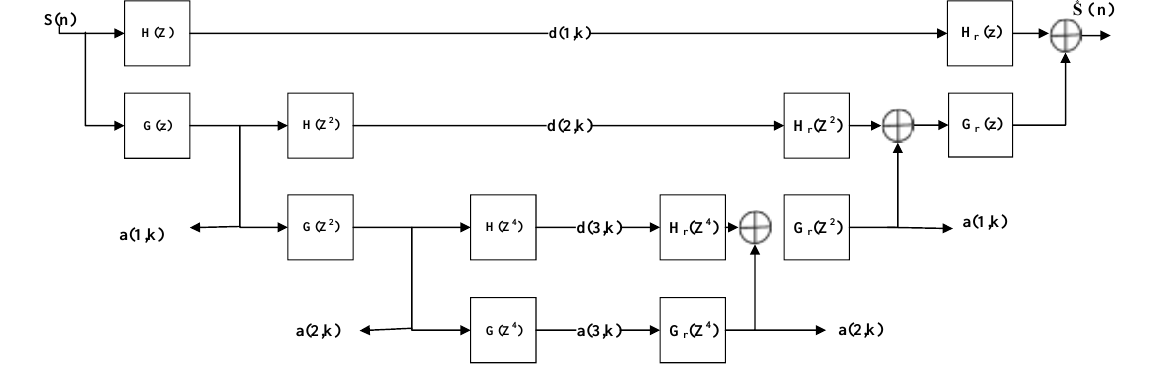
Figure 2. Block diagram of SWT. H(z) and Hr(z) are the decomposition and reconstruction high pass filters. G(z) and Gr(z) are low pass filters. Term d(·, ·) denotes the decomposition coefficients and a(·, ·) denotes the approximation coefficients.